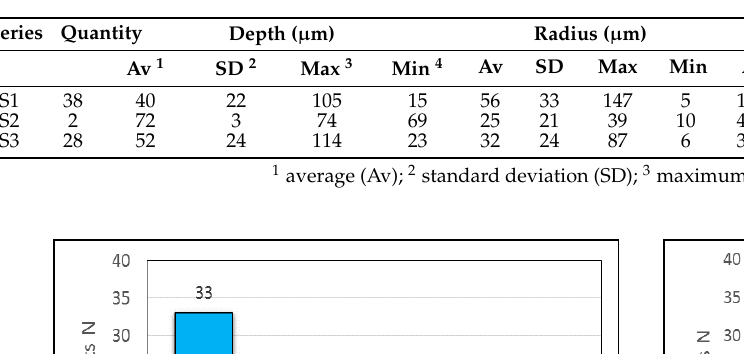
Table 7. Parameters of the undercut geometry.